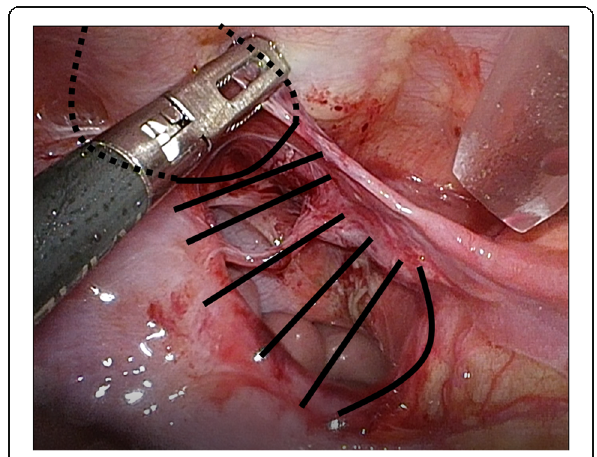
Fig. 4 Schematic illustration of each stitch. The most medial stitch partially passed the pericardium